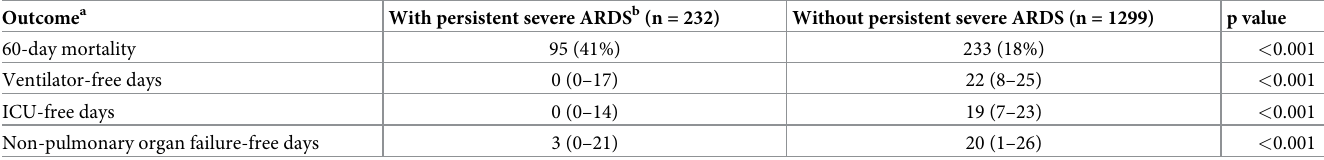
Table 2. Outcomes of patients with versus without persistent severe ARDS.